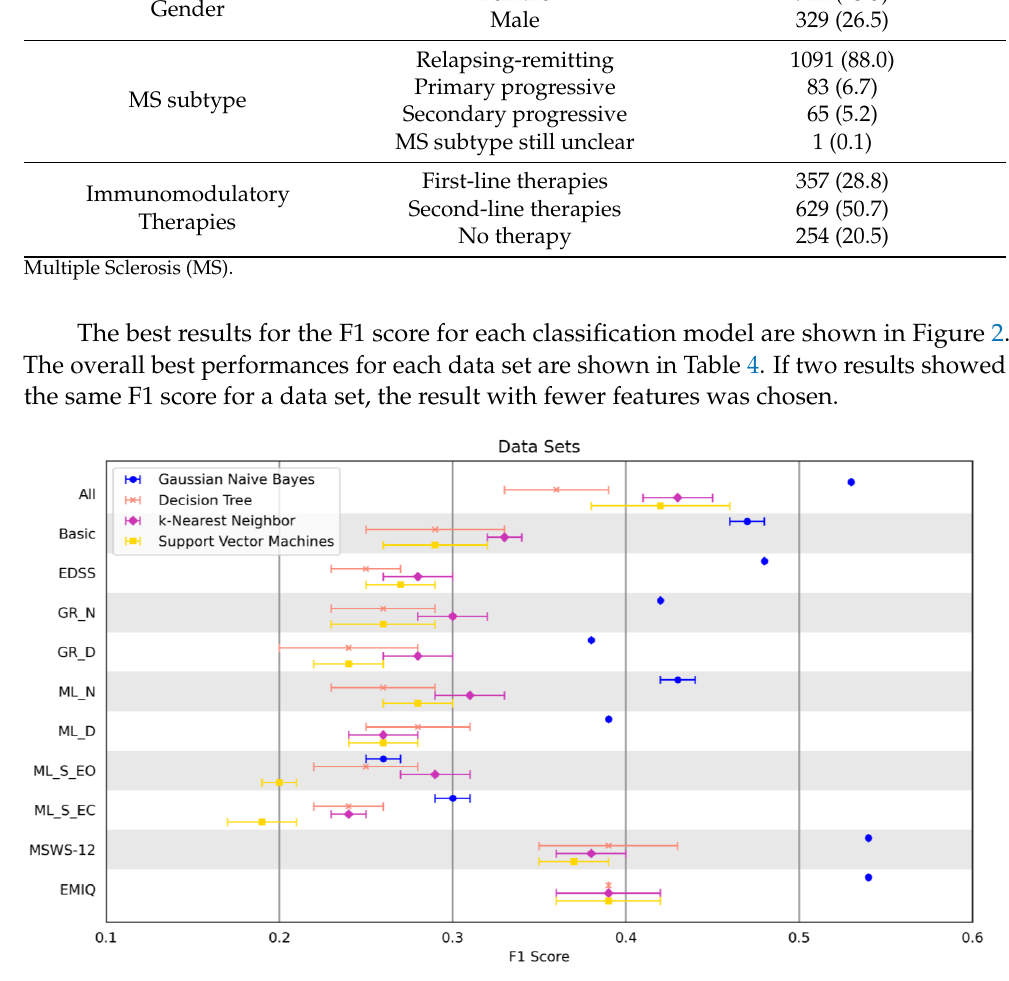
Figure 2. Best Performance (F1 score) of the four classification models on the detection of fall using different data sets. The error bars present the mean and standard deviation across 5-fold cross- validation repetition. All data set = All features of the following data sets; Basic data set = 25 Foot Walk Test + 2-minute walk test + EDSS; Expanded Disability Status Scale (EDSS); GAITRite System normal ( GR_N data set ) and dual-task ( GR_D data set ) walking; Mobility Lab Gait normal ( ML_N data set ) and dual-task ( ML_D data set ) walking; Mobility Lab Romberg stance with open ( ML_S_EO data set ) and closed eyes ( ML_S_EC data set ); Twelve Item Multiple Sclerosis Walking Scale (MSWS-12); Early Mobility Impairment Questionnaire